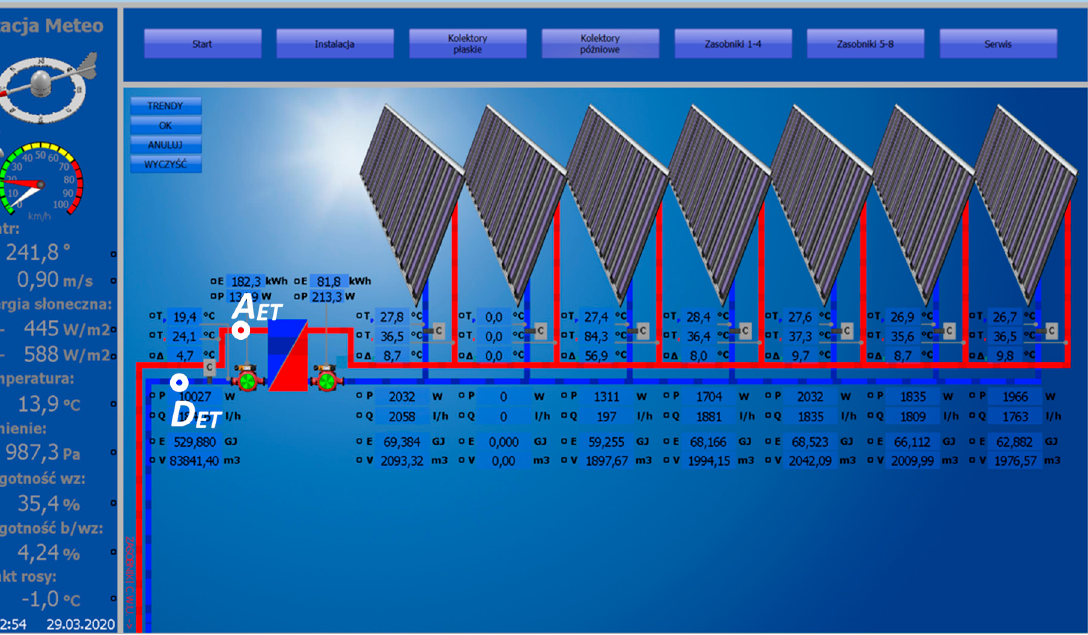
Figure 5. Screenshot of the monitoring system—loop of evacuated tube solar collectors.